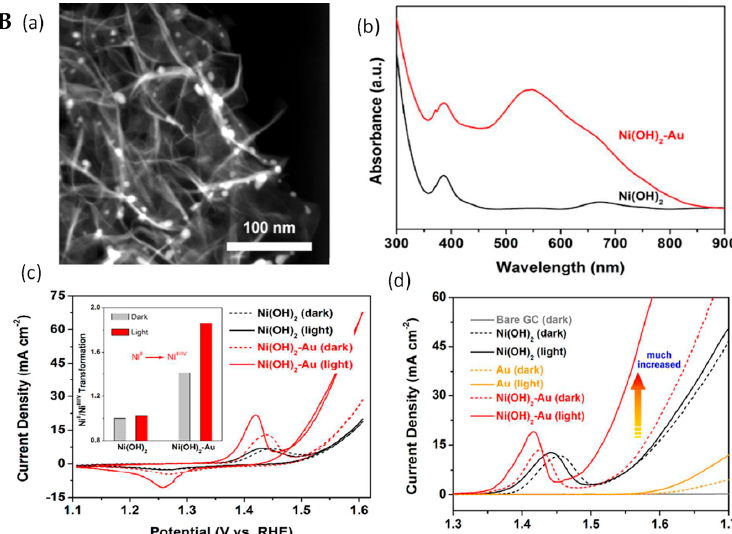
Figure 4. ( A ) ( a ) TEM image of Au–MnO 2 nanocomposite, ( b ) UV/Vis absorption spectra of MnO 2